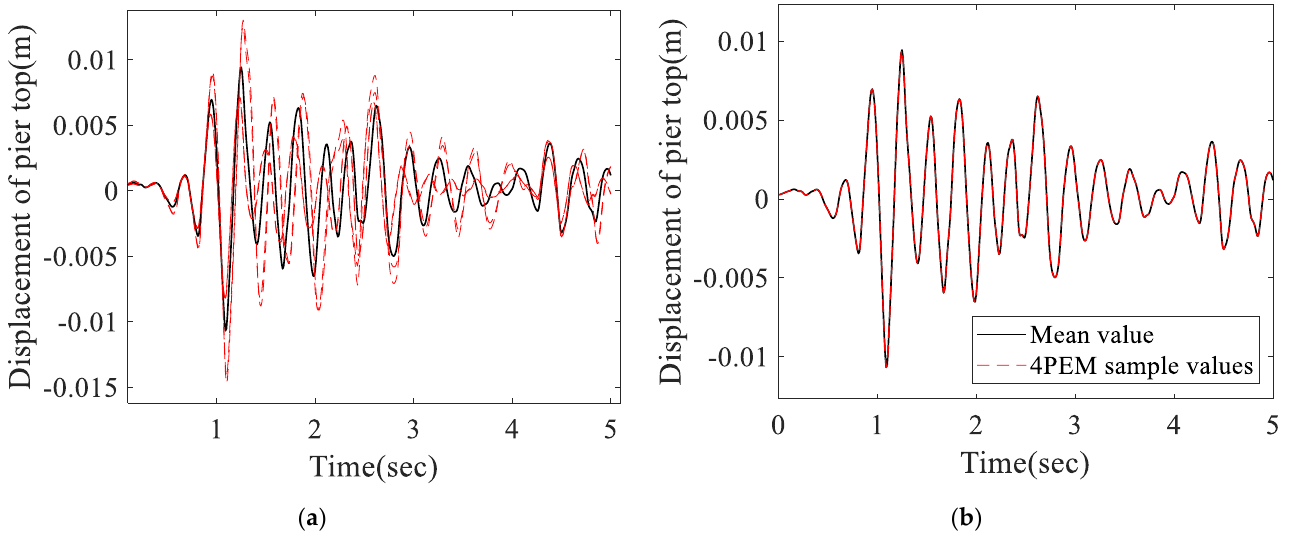
Figure 5. Time history of pier top displacement sensitivity performance. ( a ). Sensitivity of f cc . ( b ). Sensitivity of f y .